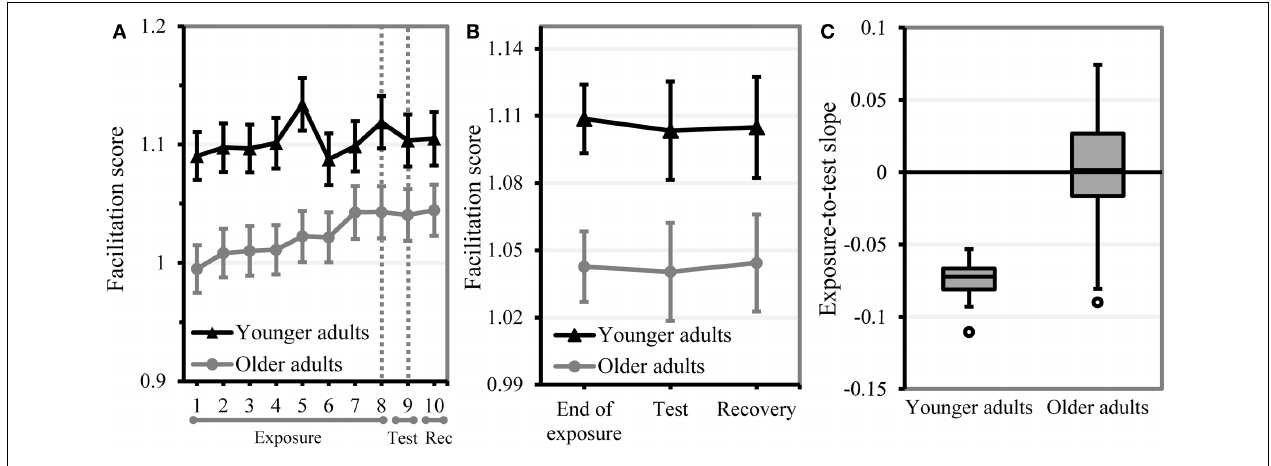
FIGURE 3 | Performance on the statistical learning task. A drop in facilitation score from the end of the exposure phase (blocks 7–8) to the test phase (block 9) indicates learning. Error bars indicate two standard errors from the mean. (A) Mean statistical learning performance per age group and block. The area between the dotted lines represents where the effect of